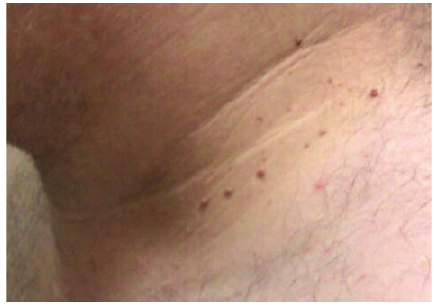
Figure 1: Lateral view of the neck.